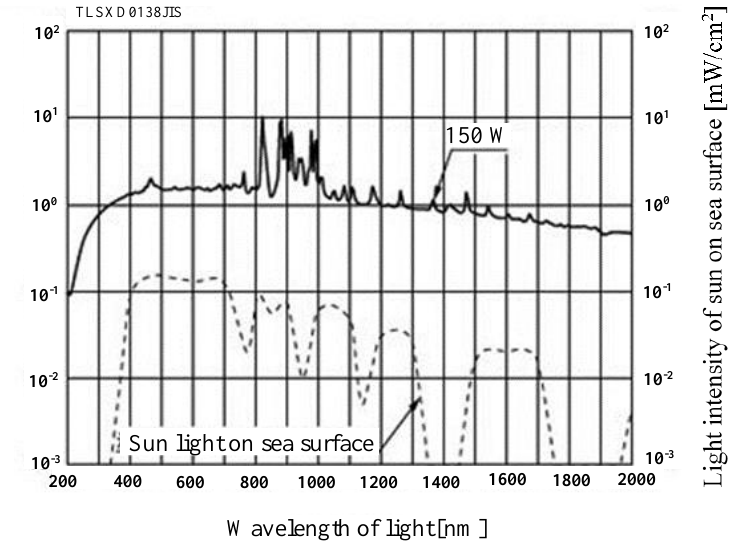
Figure 14. Spectra data on light intensity of Xe lamp without edge filter.